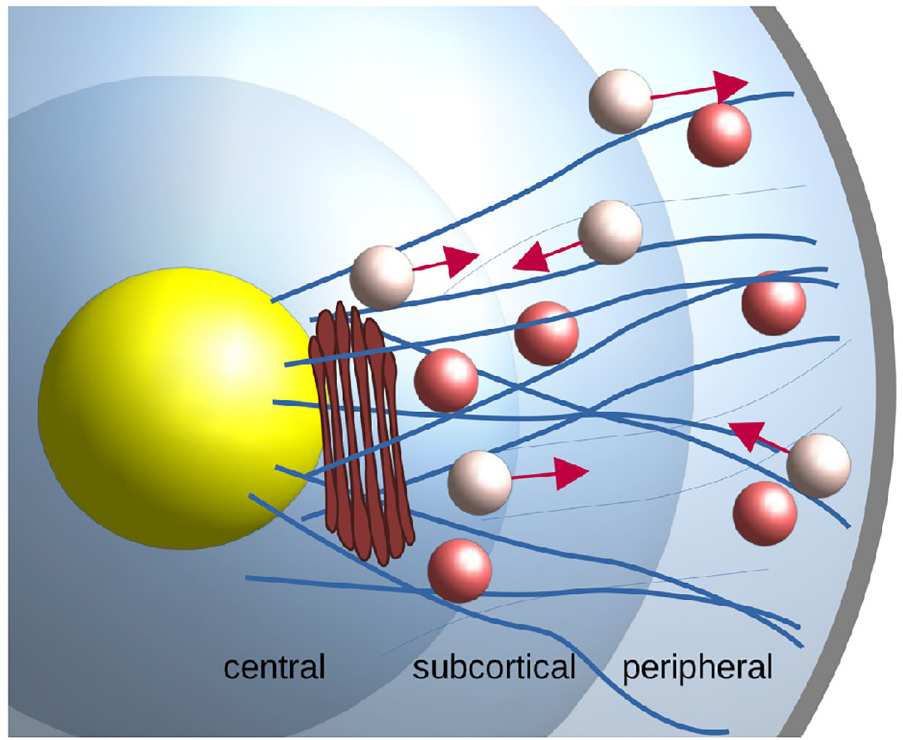
Fig 1. Sketch of secretory vesicle transport between the Golgi apparatus (brown) and the cortical actomyosin network in chromaffin cells (grey). Microtubules are shown as thick blue curves, actin filaments as thinner fibres. Secretory vesicle currently undergoing transport are represented by the lighter coloured spheres with arrows denoting the direction of transport whereas the darker spheres represent vesicles that are freely diffusing in the